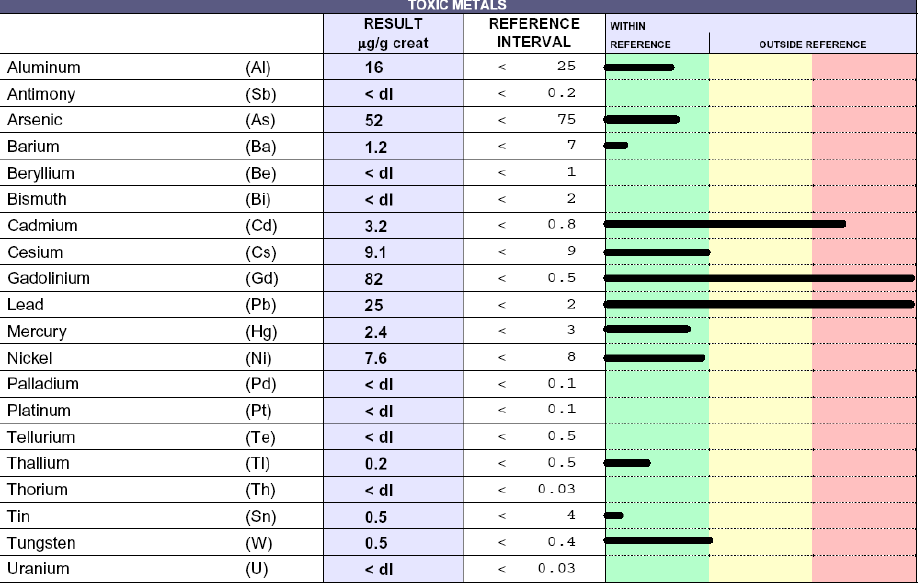
Figure 3. Toxic-metal levels measured by inductively coupled plasma mass spectrometry in patient urine collected during the 12 h following the ethylenediaminetetraacetic acid (EDTA) challenge (chelation test) reported in µg/g creatinine. The black lines indicate the levels of each toxic metal. Whitin the green column the values are considered normal, while in the yellow and in the red columns high and very high values are reported, respectively. The 42-year-old male patient was affected by multiple sclerosis and was a smoker.